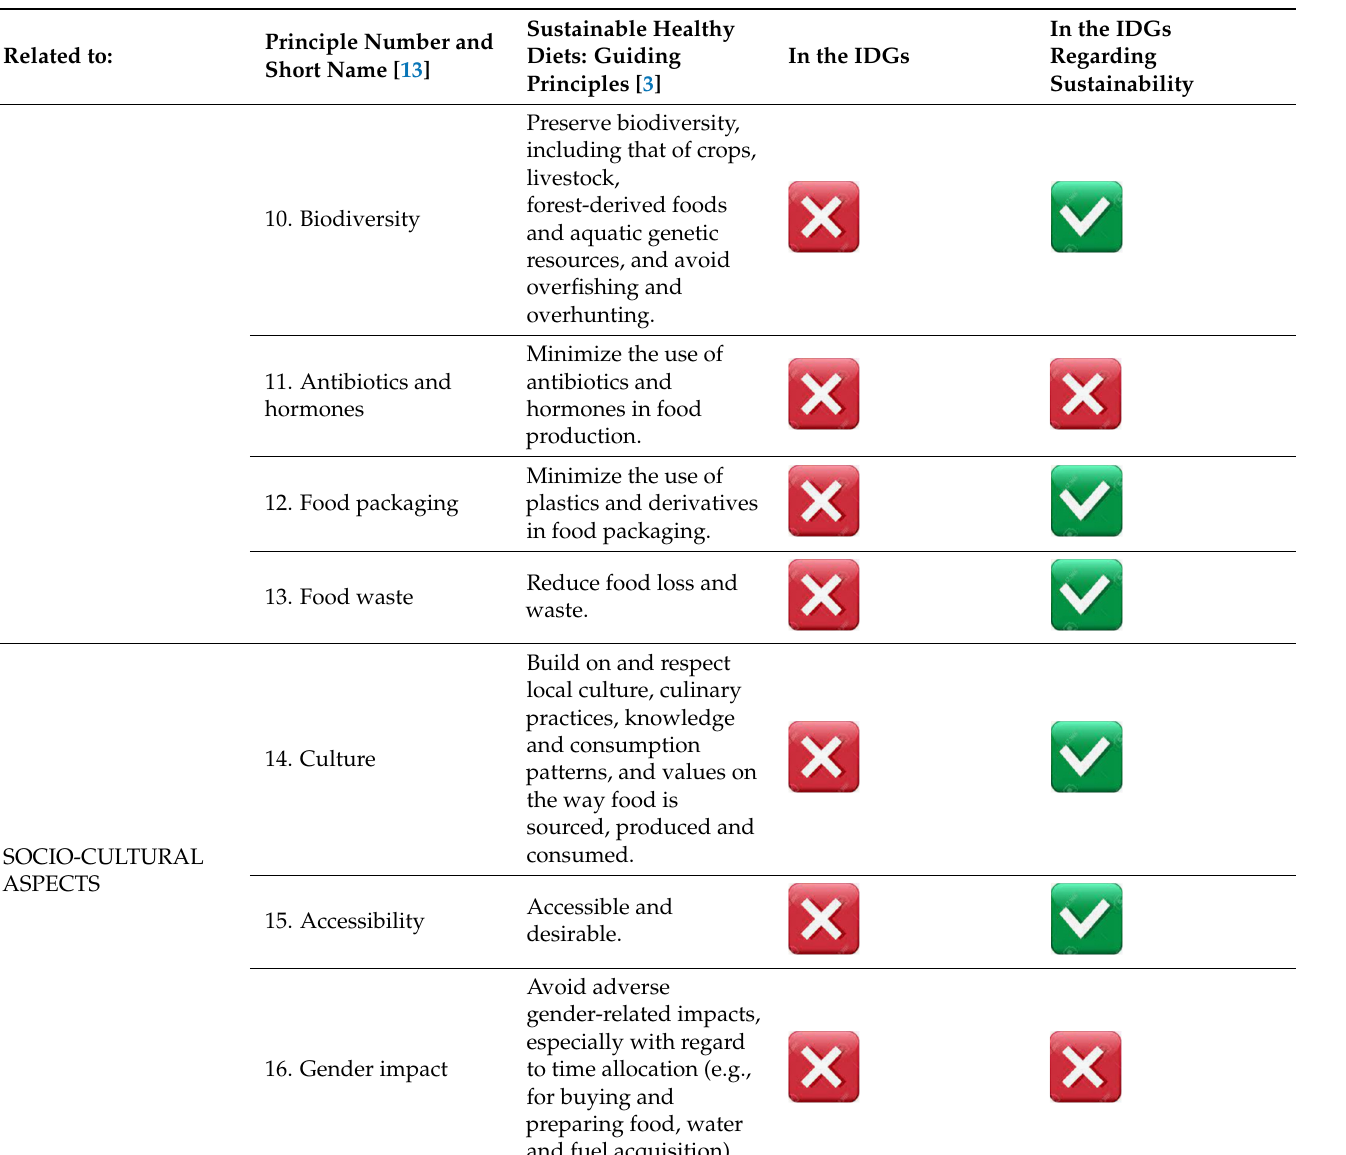
Table 1. The 16 guiding principles of a sustainable healthy diet in the IDGs regarding sustainability. Key to symbols: included; not included. Table 1. Cont.